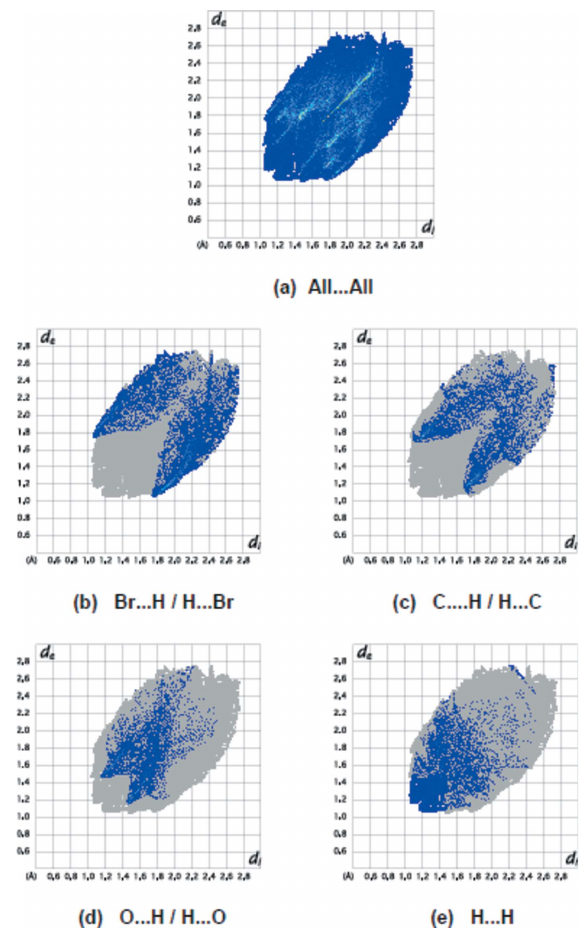
Figure 6 The full two-dimensional fingerprint plots for the title compound, showing all interactions ( a ) and delineated into ( b ) Br (cid:2)(cid:2)(cid:2) H/H (cid:2)(cid:2)(cid:2) Br, ( c ) C (cid:2)(cid:2)(cid:2) H/H (cid:2)(cid:2)(cid:2) C, ( d ) O (cid:2)(cid:2)(cid:2) H/H (cid:2)(cid:2)(cid:2) O, and ( e ) H (cid:2)(cid:2)(cid:2) H interactions. The d i and d e values are the closest internal and external distances (in A˚ ) from given points on the Hirshfeld surface.